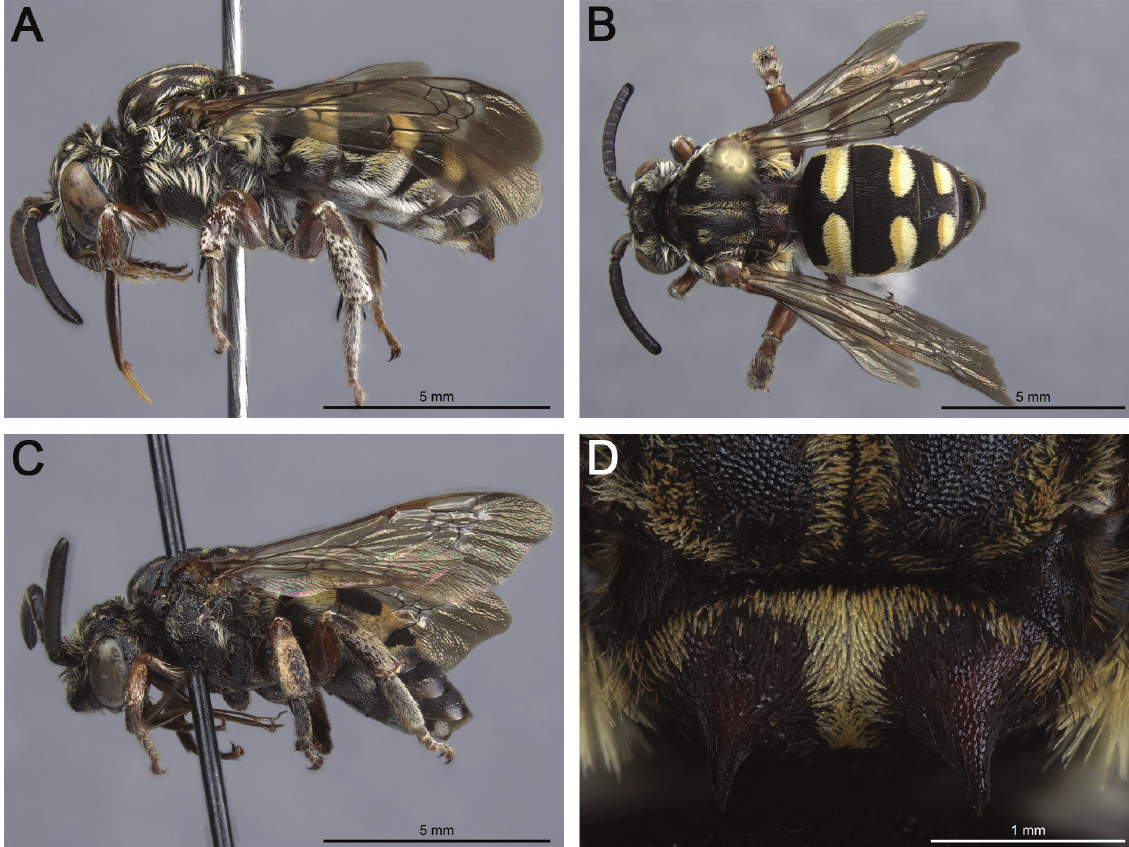
Fig. 10. Brachymelecta haitensis (Michener, 1948). A–B . Female (USNM RD-251). A Habitus, lateral view. B Habitus, dorsal view. C . Male (JAG), habitus, lateral view. D . Female (PCYU), axillae and mesoscutellum, dorsal